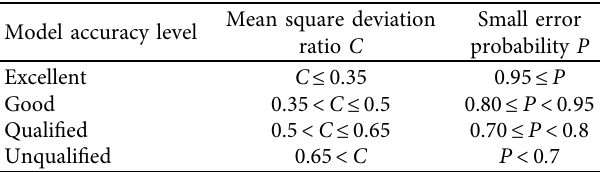
Figure 17: The comparison of the actual and predicted data of the steam generator pressure. Table 4: The precision inspection level reference table.